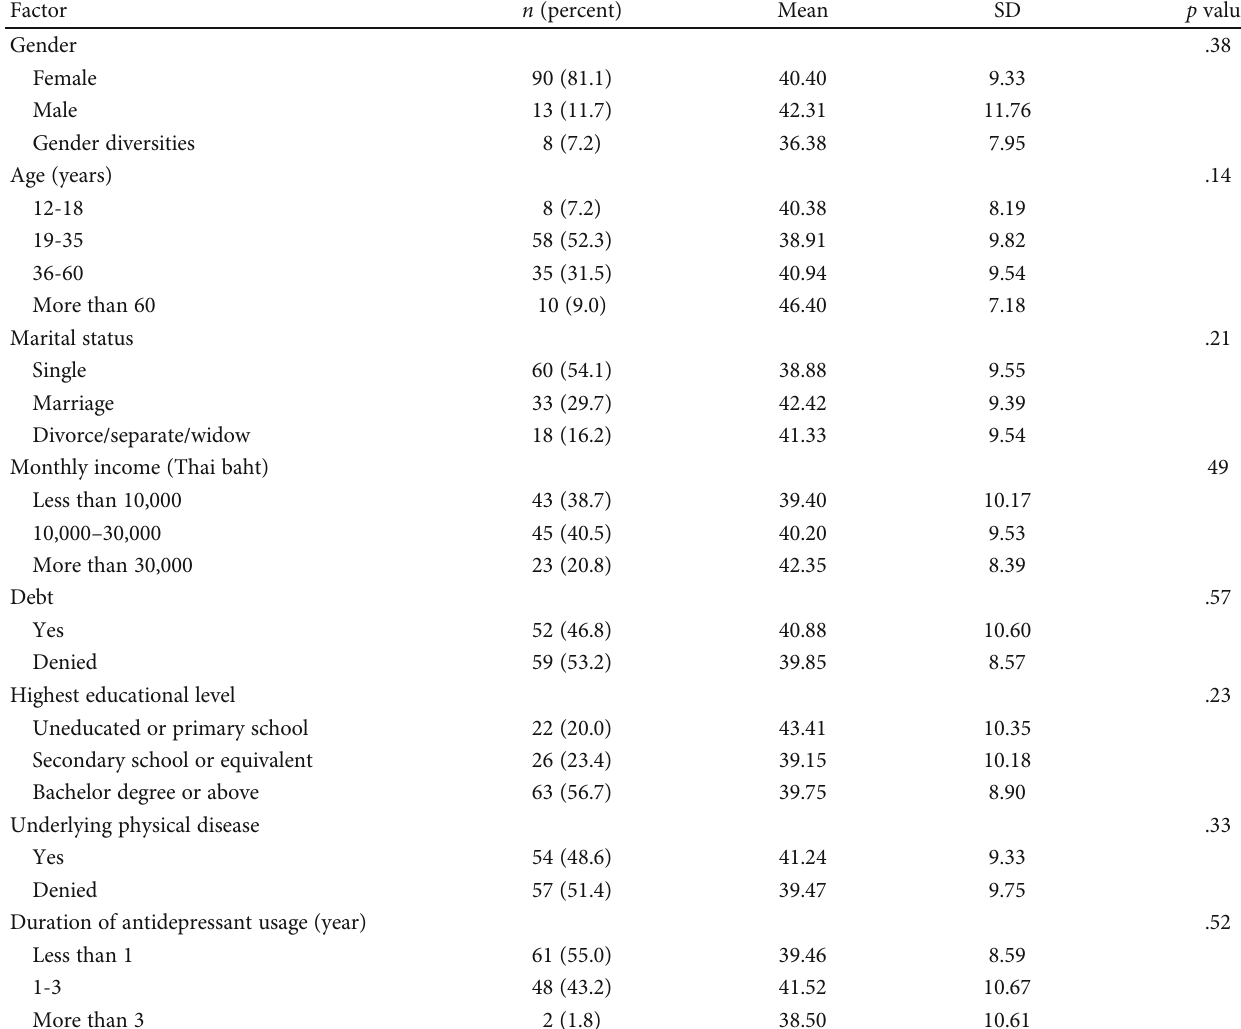
Table 2: Factors related to social-psychological well-being among MDD patients ( n = 111